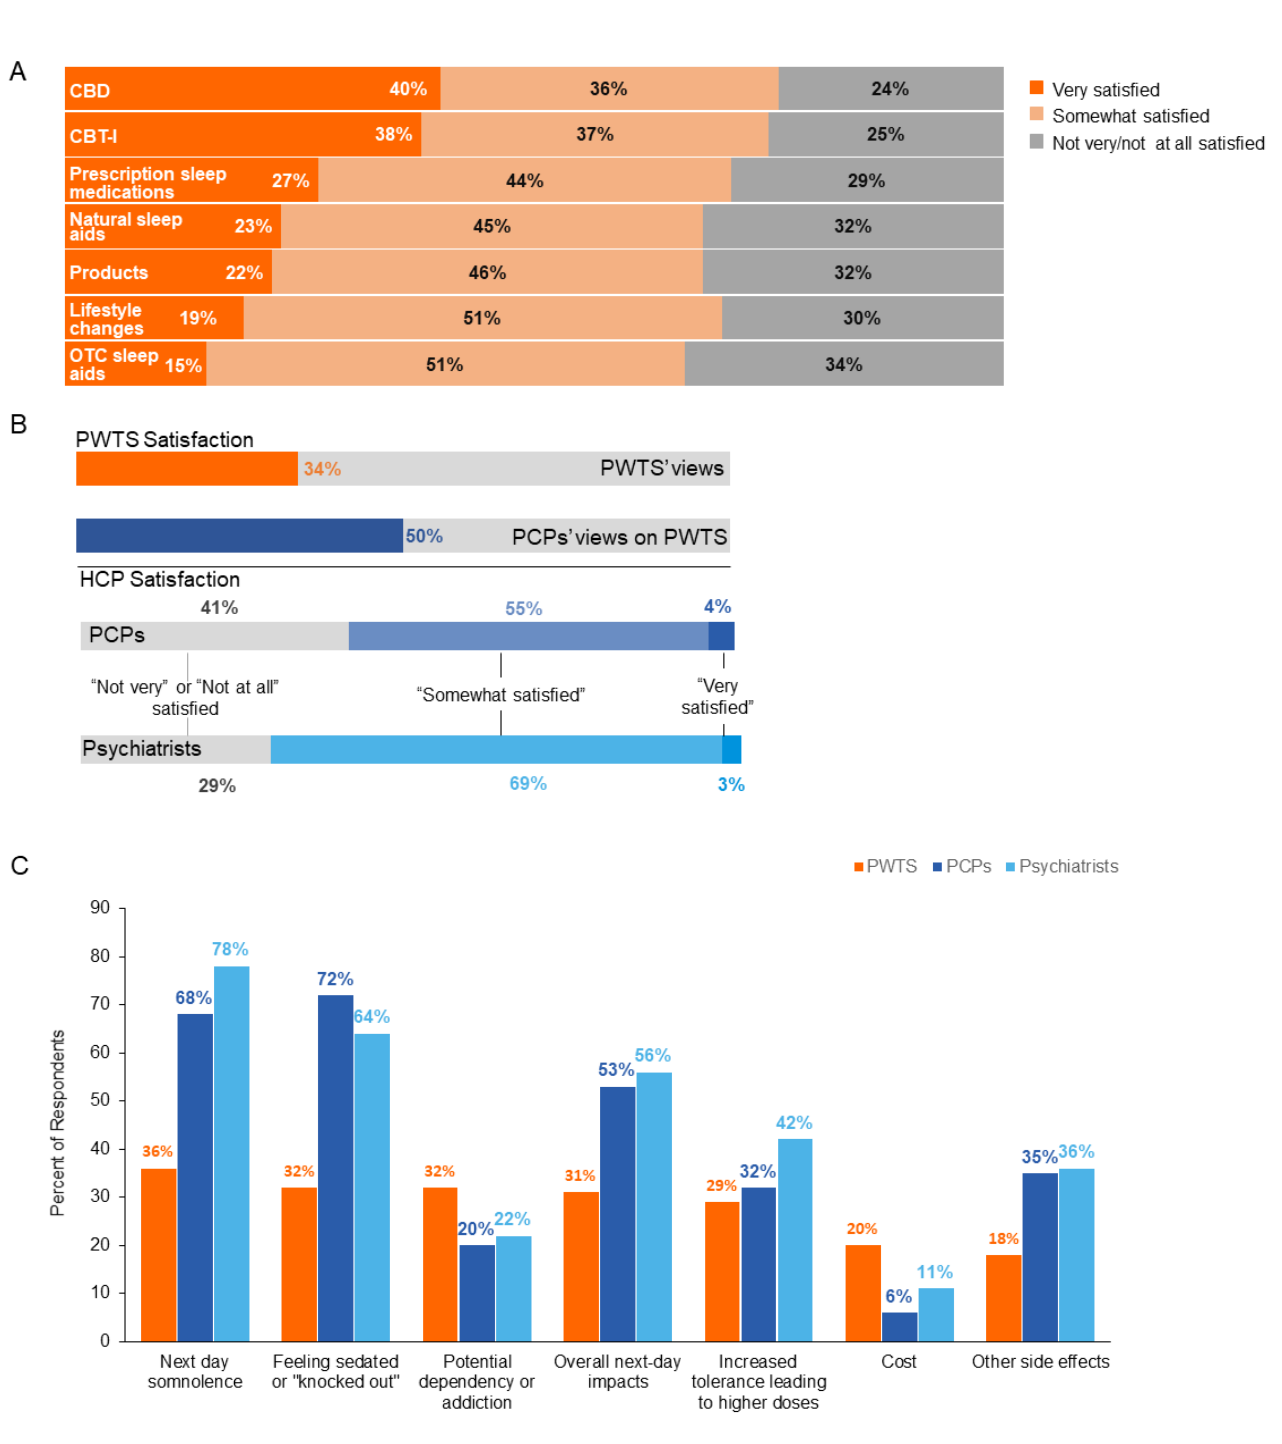
Figure 3. PWTS satisfaction with each treatment/solution currently being used, overall satisfaction with current pharmacologic treatment options, and the top concerns about OTC sleep aids for trouble sleeping/insomnia for PWTS, PCPs, and psychiatrists. ( A ) PWTS reported satisfaction with their current treatment. ( B ) PWTS overall satisfaction with current pharmacologic treatments, PCPs’ views on PWTS satisfaction, and HCP overall satisfaction. ( C ) Top concerns of PWTS, PCPs, and psychiatrists about OTC sleep aids for trouble sleeping/insomnia. CBD, cannabidiol; HCP, health care professional; OTC, over the counter; PCP, primary care physician; PWTS, people with trouble sleeping.